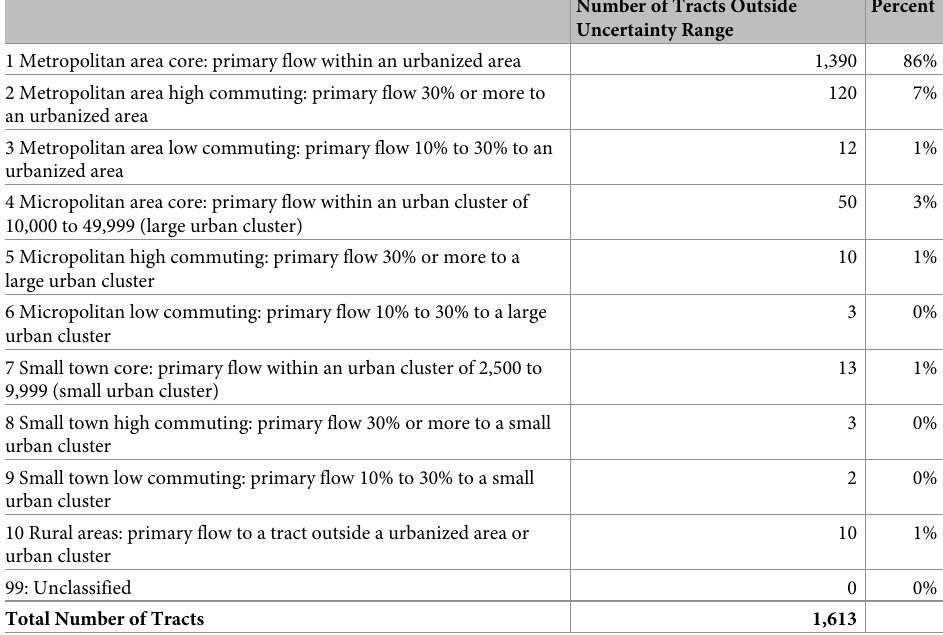
located in states with rapidly growing metropolitan areas, including Texas, California, Flor- ida, and Georgia. In Texas, 238 tracts account for just under 15% of all tracts outside the +/-5 deviation metric, followed by California, which has 222 tracts that make up another 14% of these tracts (S1 Appendix). Table 4. Distribution of uncertainty across the urban-rural